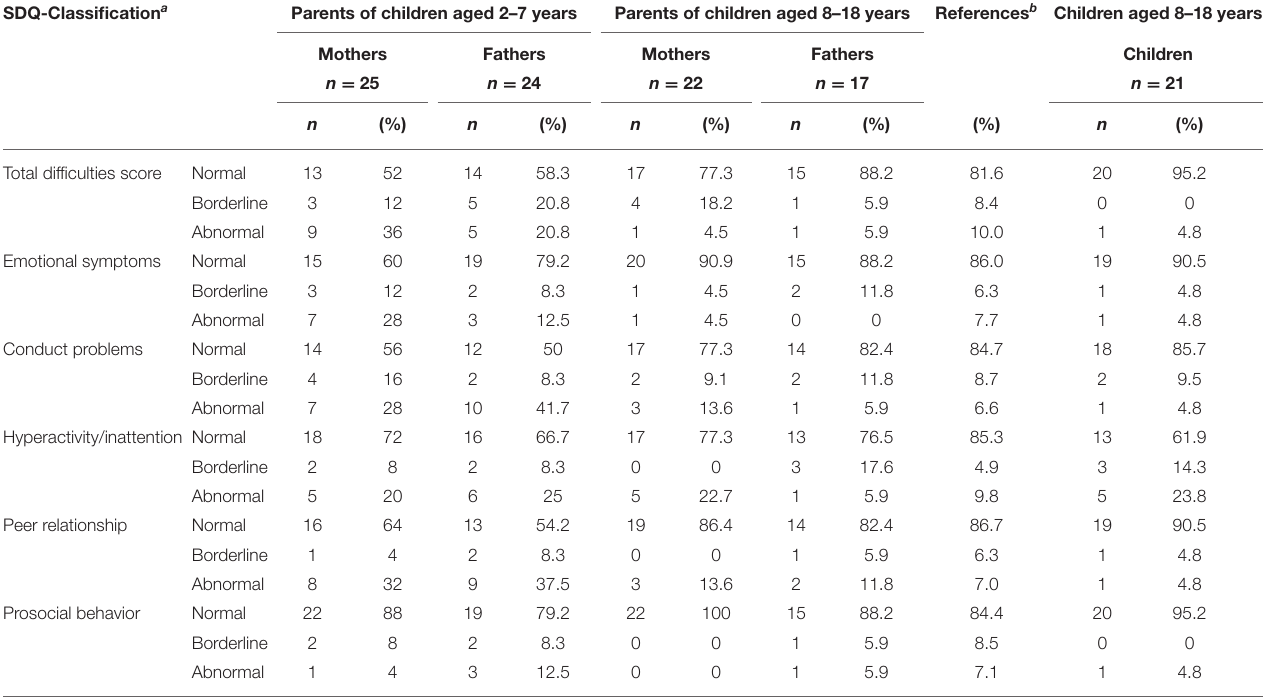
TABLE 2 | Classification of the Strengths and difficulties questionnaire. SDQ-Classification